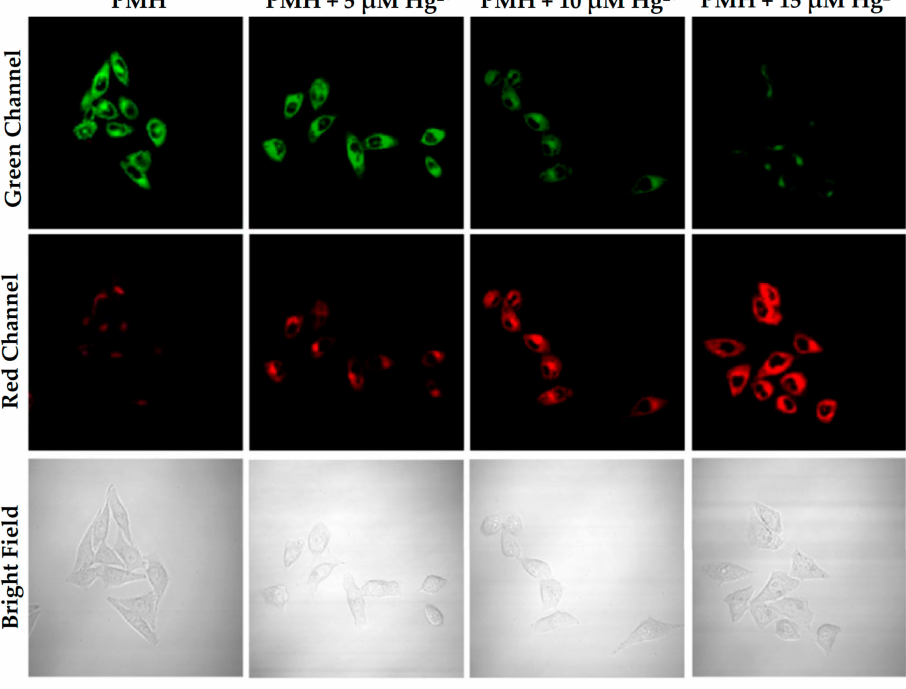
Figure 4. Confocal microscopy images of MCF-7 cells with PMH and Hg 2 + ions (excited at 405 nm).treated with PMH (1 µ M) and Hg 2 + ions (0 µ M, 5 µ M, 10 µ M, 15 µ M) Green Chanel: fluorescent image of emission between 430–460 nm; Red Channel: fluorescent image of emission between 490–550